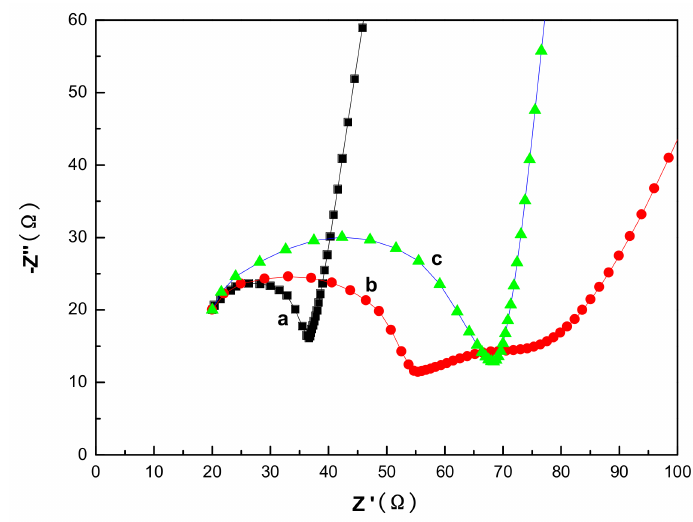
Figure 6. EIS of ZnS-GQDs (a), ZnS-graphene (b) and pure ZnS